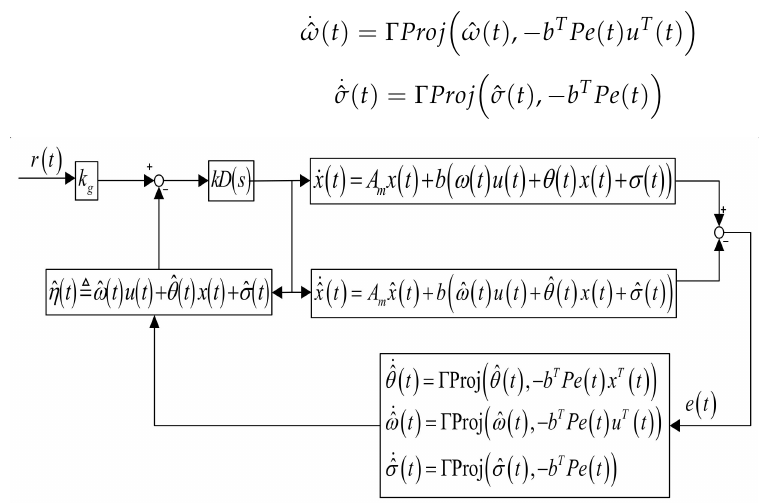
Figure 4. Closed-loop L 1 adaptive controller